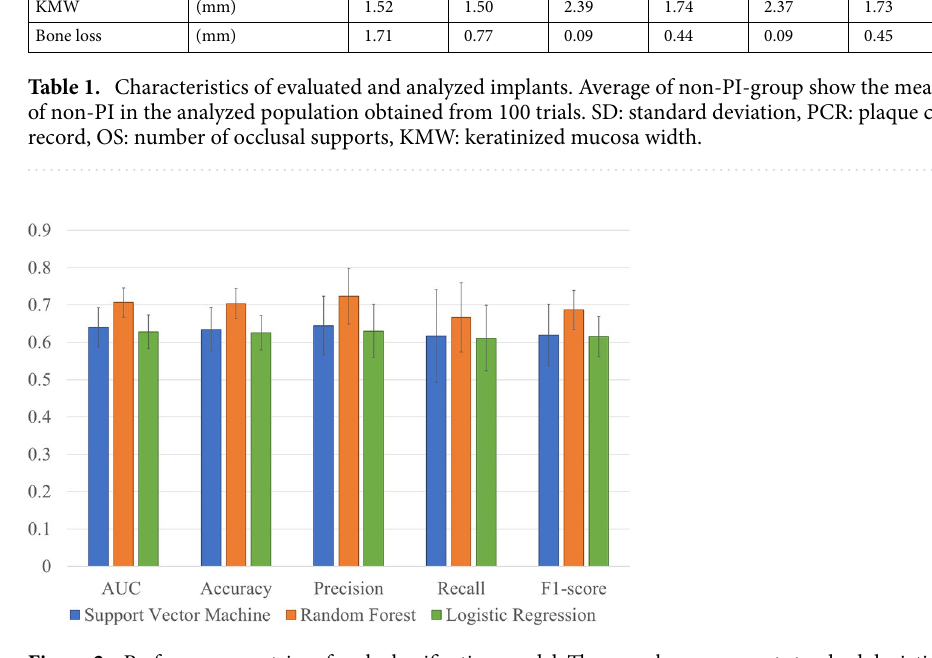
Figure 2. Performance metrics of each classification model. The error bars represent standard deviation. AUC: area under the receiver operating characteristic curve. This figure was created with Excel 2019 version 1808 (Microsoft, Inc, Redmond,